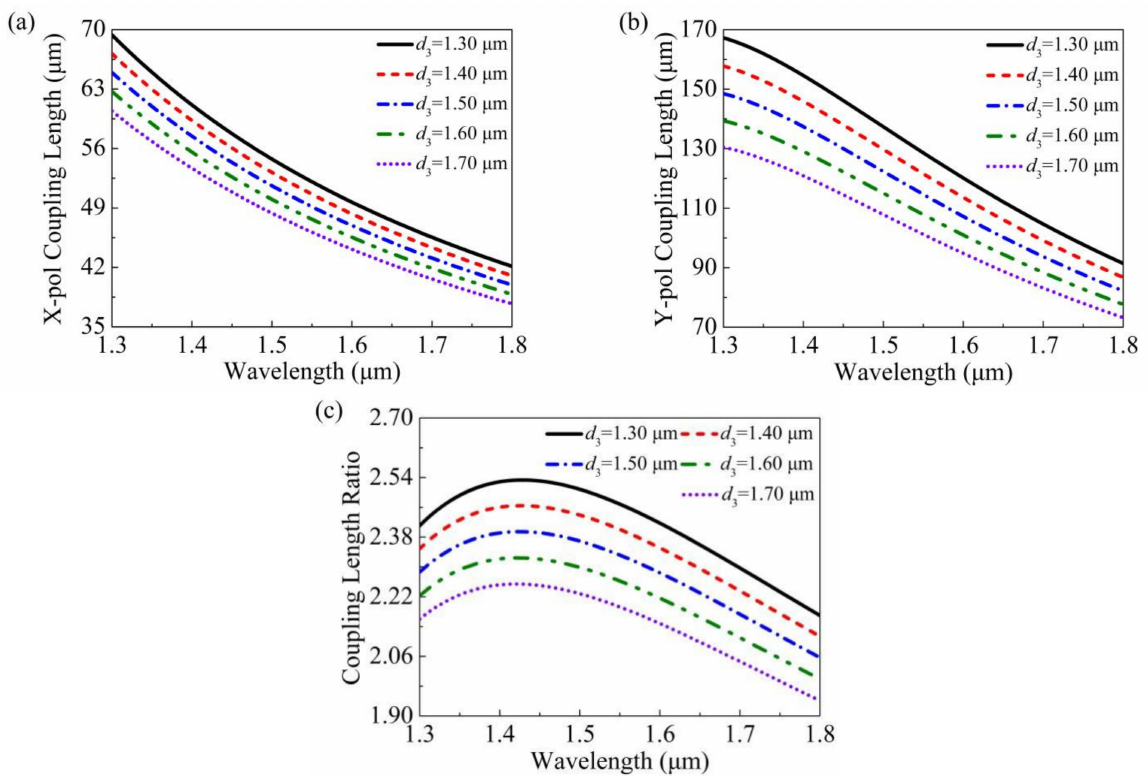
Figure 8. The change rules of the ( a ) CL X , ( b ) CL Y , and ( c ) CLR of the LC-DC-PCF with wavelengths for different d 3